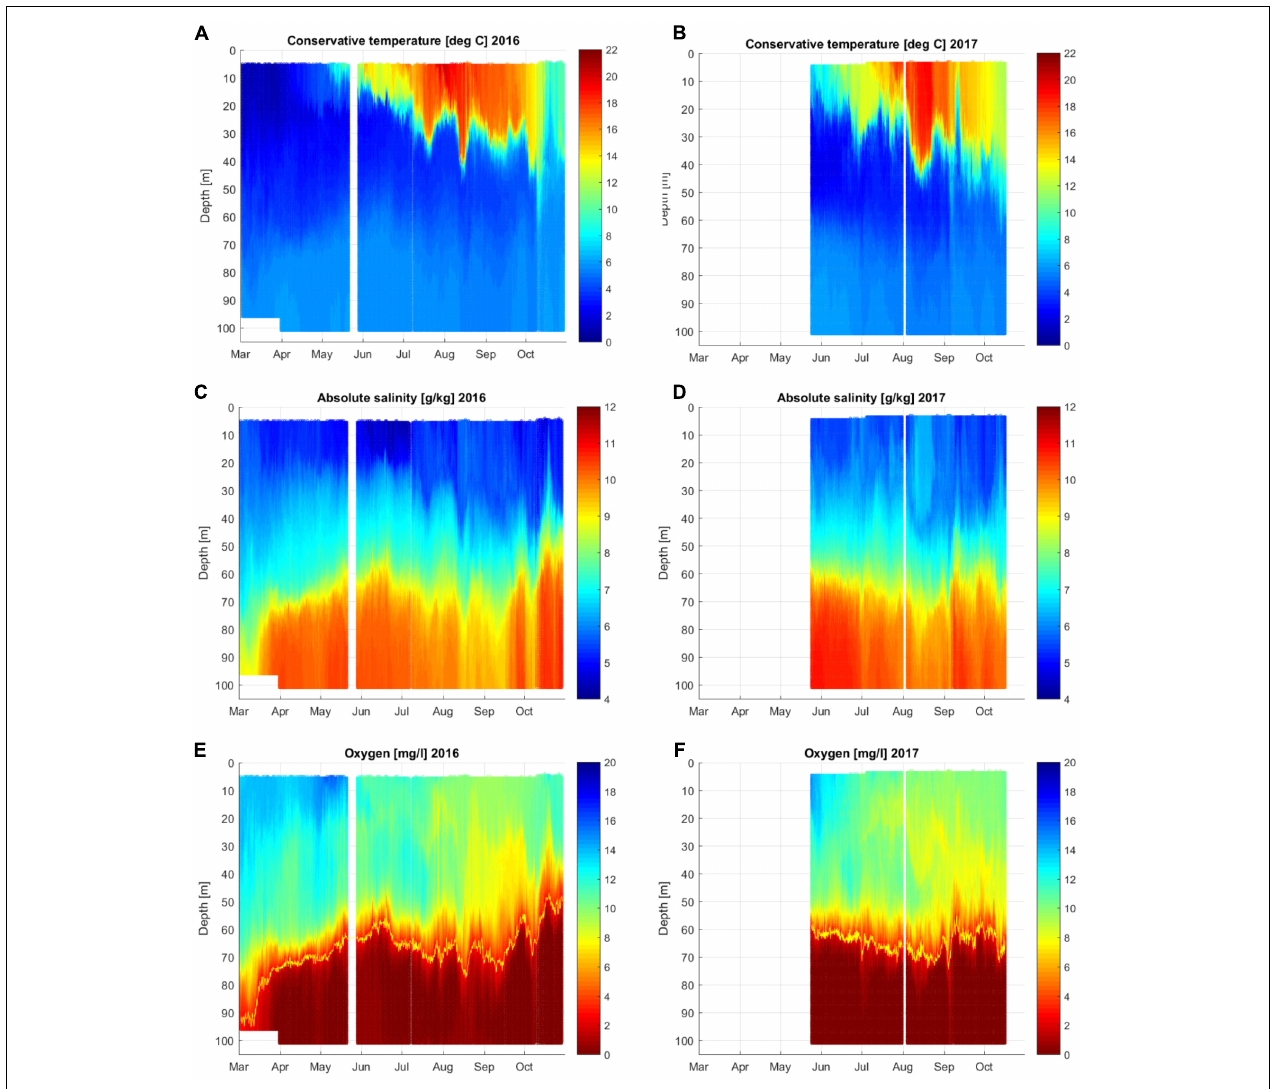
FIGURE 3 | Temporal variability of vertical distributions of temperature (A,B) , salinity (C,D) and dissolved oxygen concentration (E,F) at the Keri bottom-mounted station in the GoF in 2016 and 2017. The yellow line in the lower panel shows the border of hypoxia (2.9 mg · l − 1 ). White strips/areas indicate periods when no data was